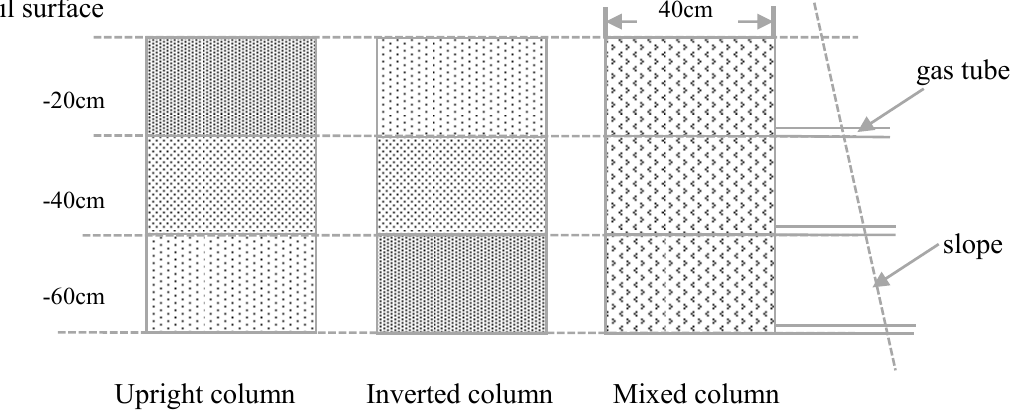
Figure A1. Diagram depicting soil column manipulation for field measurements of CO 2 .